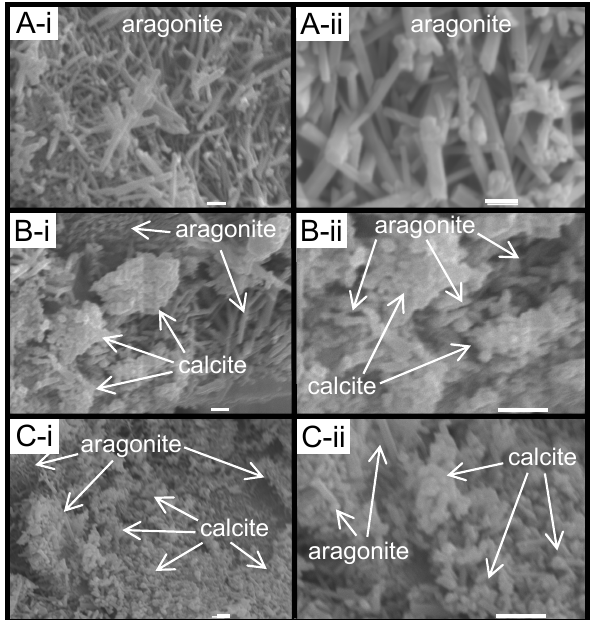
Fig. 5. Back-scatter electron images showing the distribu- tion of the aragonite and calcite precipitated within the in- terutricular space of segments comprising the thalli of Hal- imeda incrassata algae reared in experimental seawaters with Mg/Ca=5.2 and [Ca 2 + ]=10.2mmolkg-SW − 1 (aragonite seawa- ter; A-i , A-ii ), Mg/Ca=2.5 and [Ca 2 + ]=18.1mmolkg-SW − 1 (aragonite-calcite boundary seawater; B-i , B-ii ), and Mg/Ca=1.5 and [Ca 2 + ]=25.3mmolkg-SW − 1 (calcite seawater; C-i , C-ii ). Scale bars are